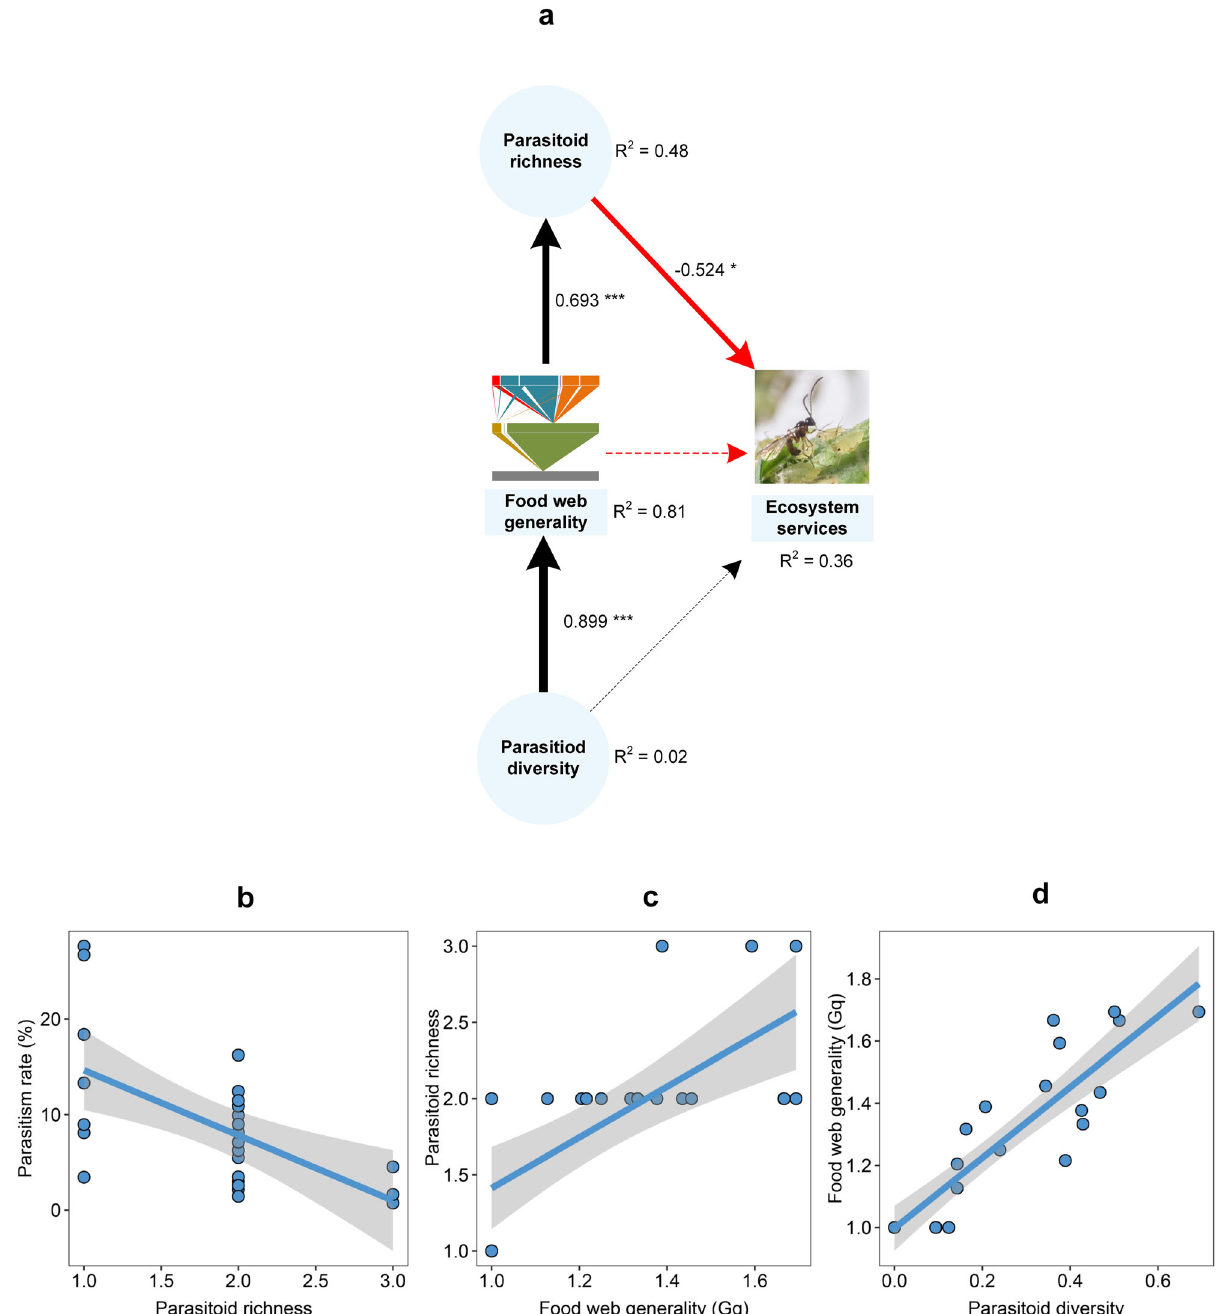
Fig. 2 Causal paths between the ecosystem service (ES) of biological control and different predictors. In the SEM analysis, ES is the ultimate response variable, while parasitoid richness, parasitoid diversity and food web generality (Gq) are both predictors and response variables. The paths reveal both direct and indirect relationships between individual predictors and response variables. a Shows the paths after removing non-crop habitat (NCH). Standardized coef fi cients are shown for each path and scaled as line width. Black and red lines indicate either positive or negative relationships, with solid lines representing statistically signi fi cant effects and dotted lines showing nonsigni fi cant effects (* P < 0.05; ** P < 0.01; *** P < 0.001). R 2 shows the explanatory proportion of the total variance for each response variable in the model (Supplementary Table 11). b – d Show signi fi cant relationships based on SEM analysis, with solid lines and shaded zones indicative of the regression lines and 95% con fi dence intervals ( n = 25),